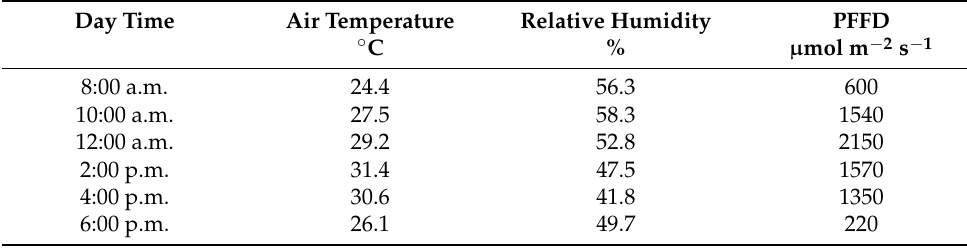
Table 2. Air temperature ( ◦ C), relative humidity of the air (%), and photosynthetic photon flux density (PPFD, µ mol m − 2 s − 1 ), from 8:00 a.m. to 6:00 p.m. under field conditions. Botucatu, SP, Brazil,